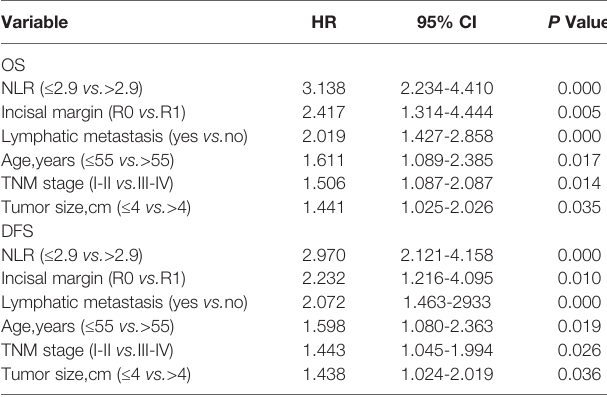
TABLE 3 | Cox multivariate proportional hazards of independent predictors on DFS and OS. Variable HR 95% CI P Value OS NLR ( ≤ 2.9 vs.